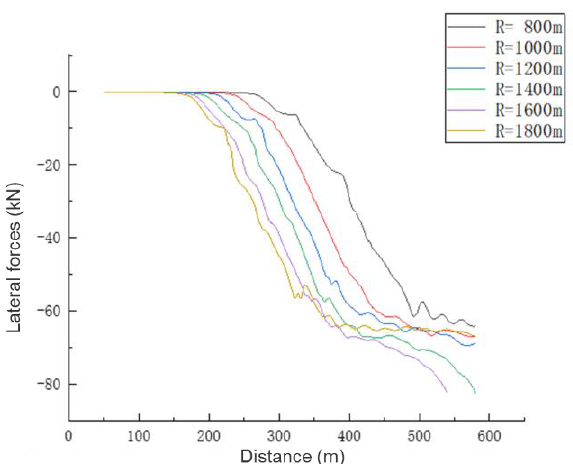
Figure 13. Variation of lateral force at critical derailment speed.